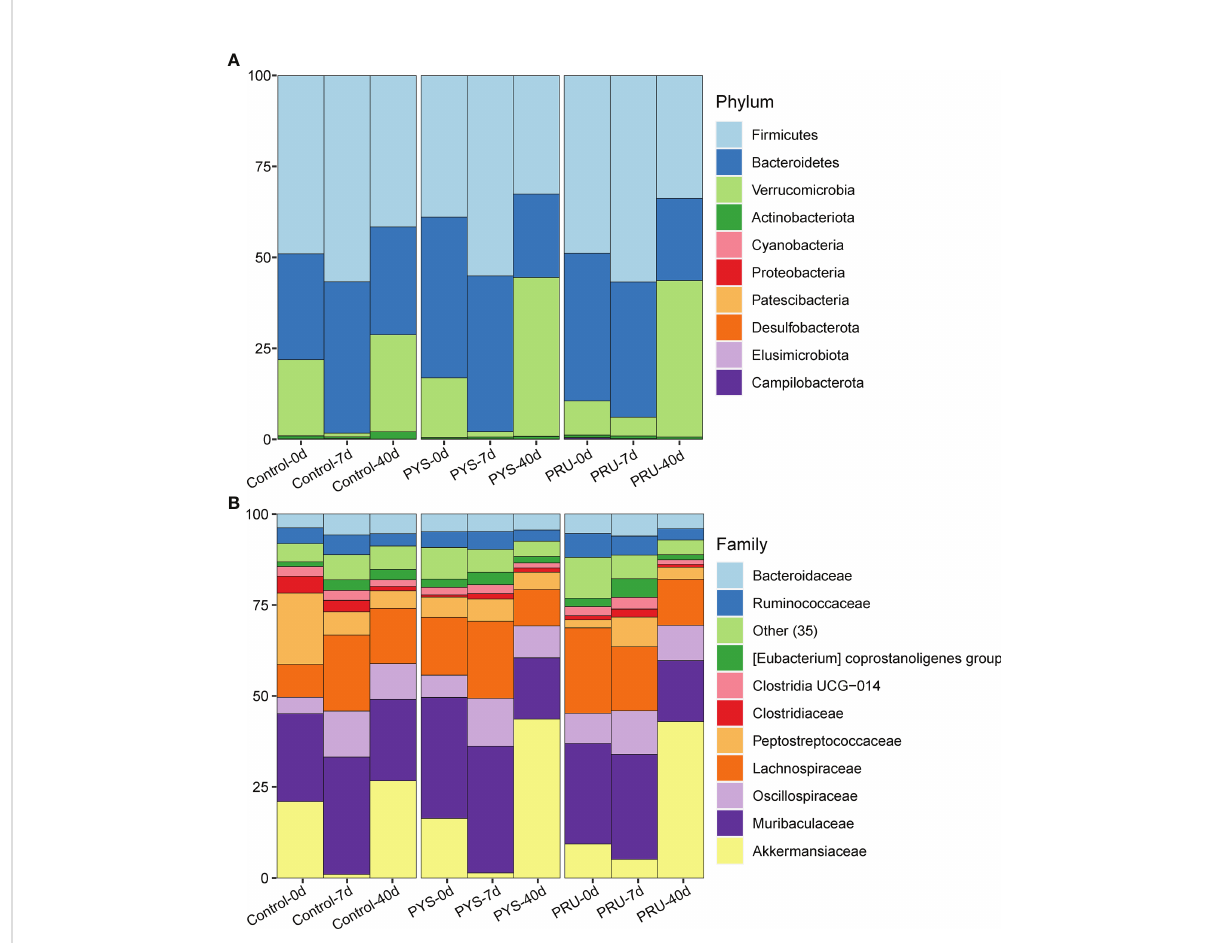
FIGURE 3 Gut microbiota structure of rats. (A) The gut microbiota structure at phylum level of each group. (B) The gut microbiota structure at the family level of each group, and only the top 10 families have the high abundance, while 35 low-abundance families are integrated into the “ Other ”